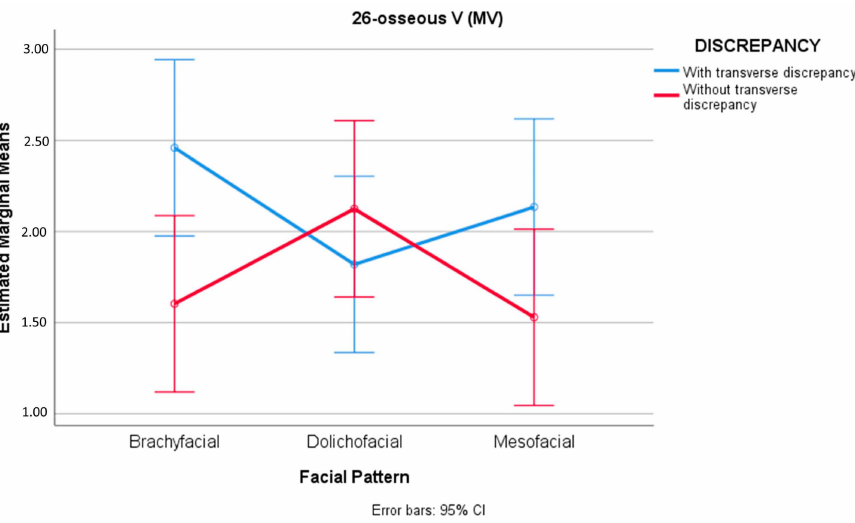
Figure 5. Transverse bone discrepancy inverts the behavior of the distance for the mesiobuccal root of the right upper first molar between patterns; in the absence of transverse bone discrepancy, the dolichofacial values tend to be greater than in the rest of the facial patterns, while in the presence of transverse bone discrepancy, the dolichofacial values are lower than in the rest of the